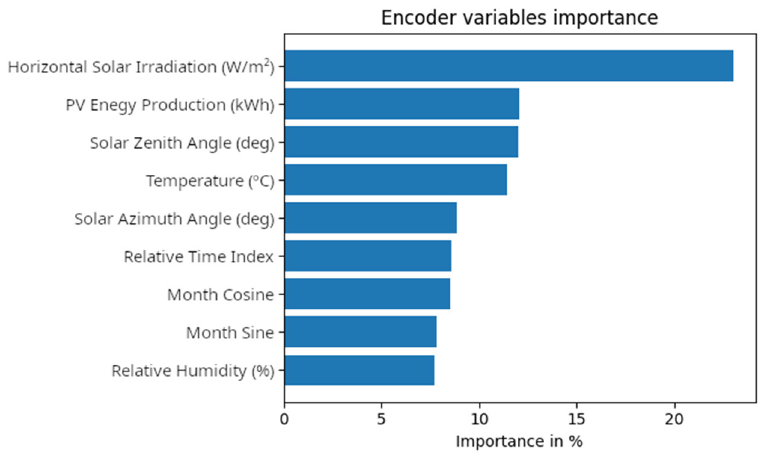
Figure 12. Importance of encoder variables.